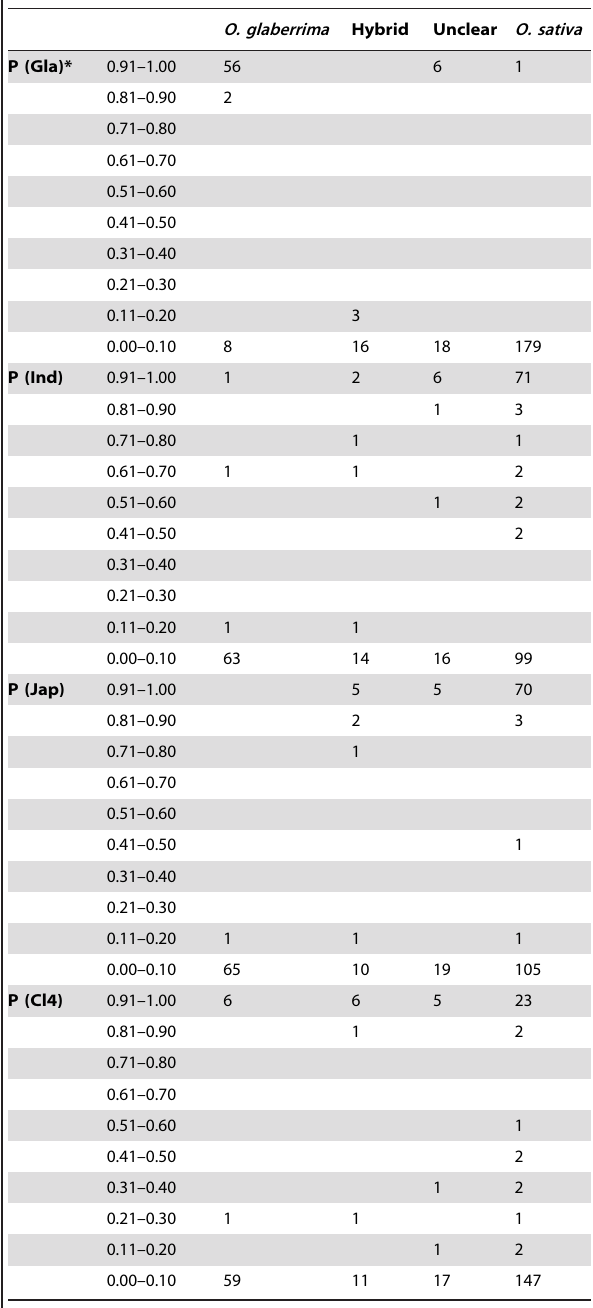
*Probabilities of the materials assigned to O. glaberrima (Gla), O. sativa ssp. indica (Ind), O. sativa ssp. japonica (Jap) and the fourth cluster